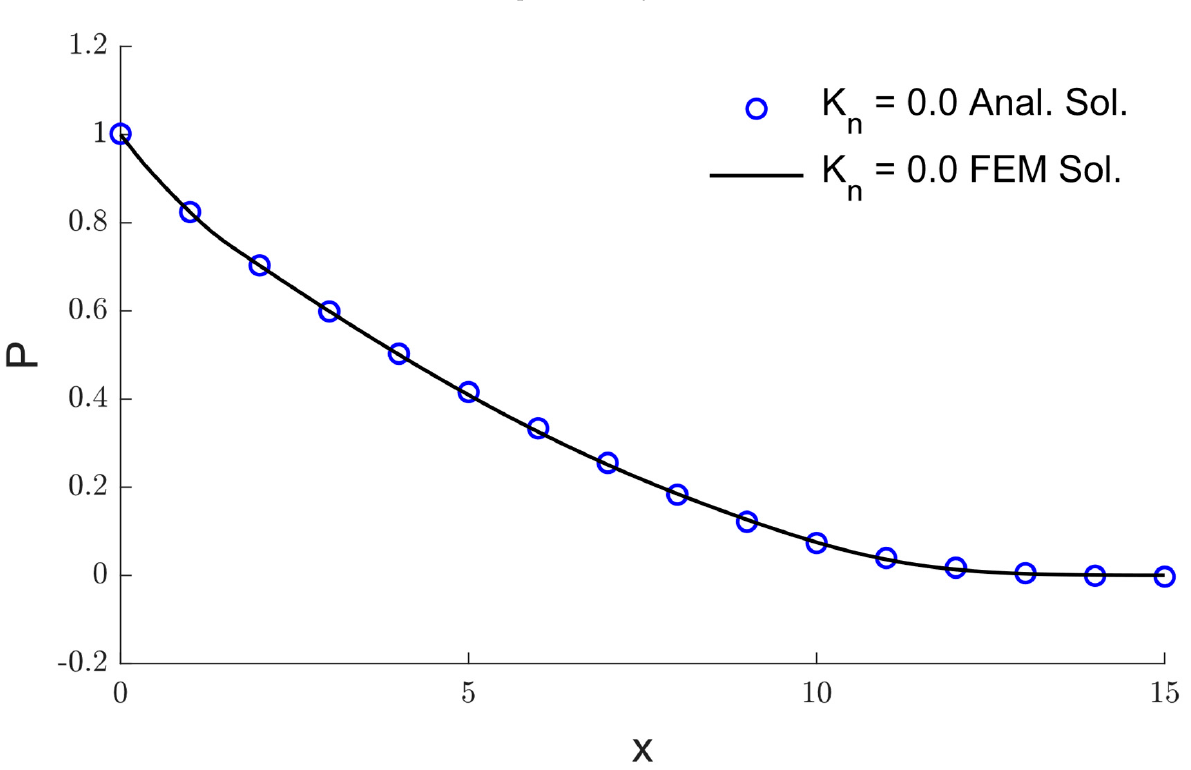
Figure 15. The chemical potential comparison study when τ o = τ 1 = 0.05 and K n = 0 .